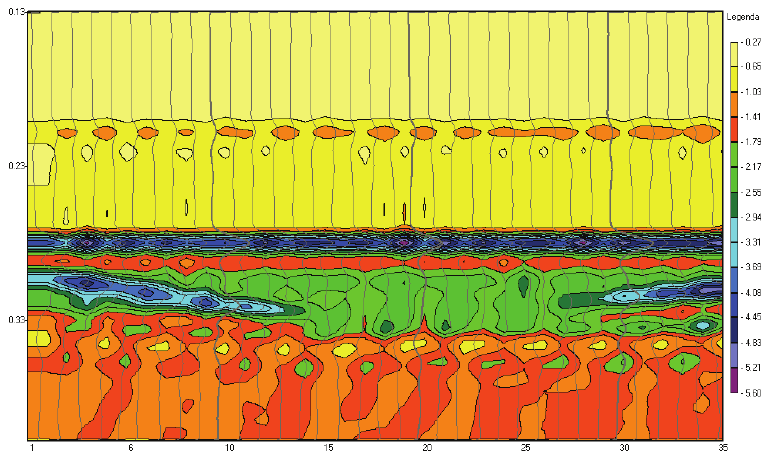
Fig. 3. Synthetic pseudoimpedance acoustic section; signal parameters: dominant frequency f 0 = 40 Hz, initial phase φ 0 = 0, the ratio of dominant frequency to dumping factor f 0 / β = 1, noise 20%